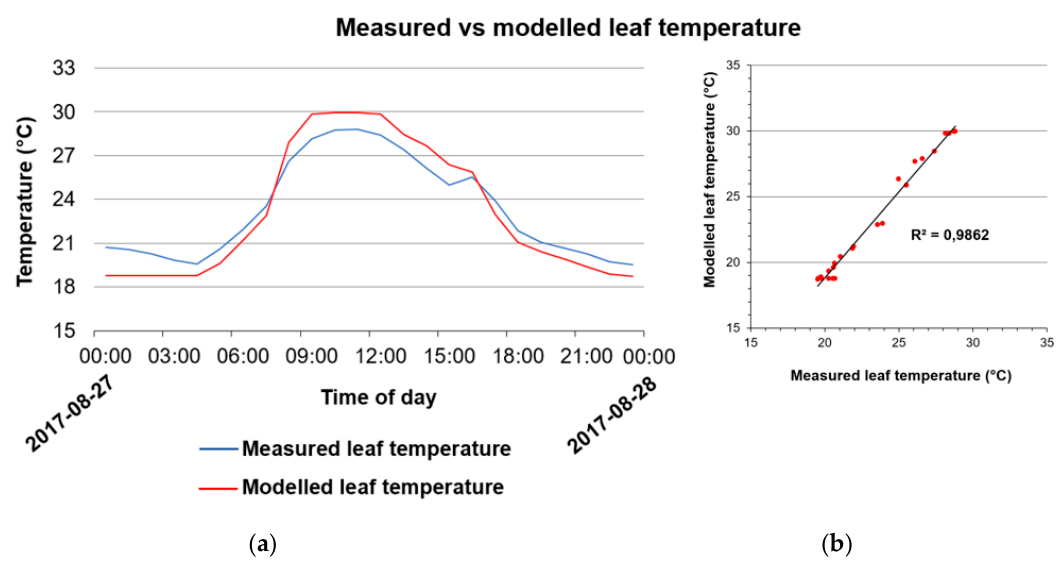
Figure 7. Comparison of the measured and modelled leaf temperature at the green roof on a sunny day 27 August 2017. ( a ) Presentation of temporal changes of the values and ( b ) Correlation analysis of the variables. The measured leaf temperature was analyzed using a median filter approach with the kernel size of 5.0.